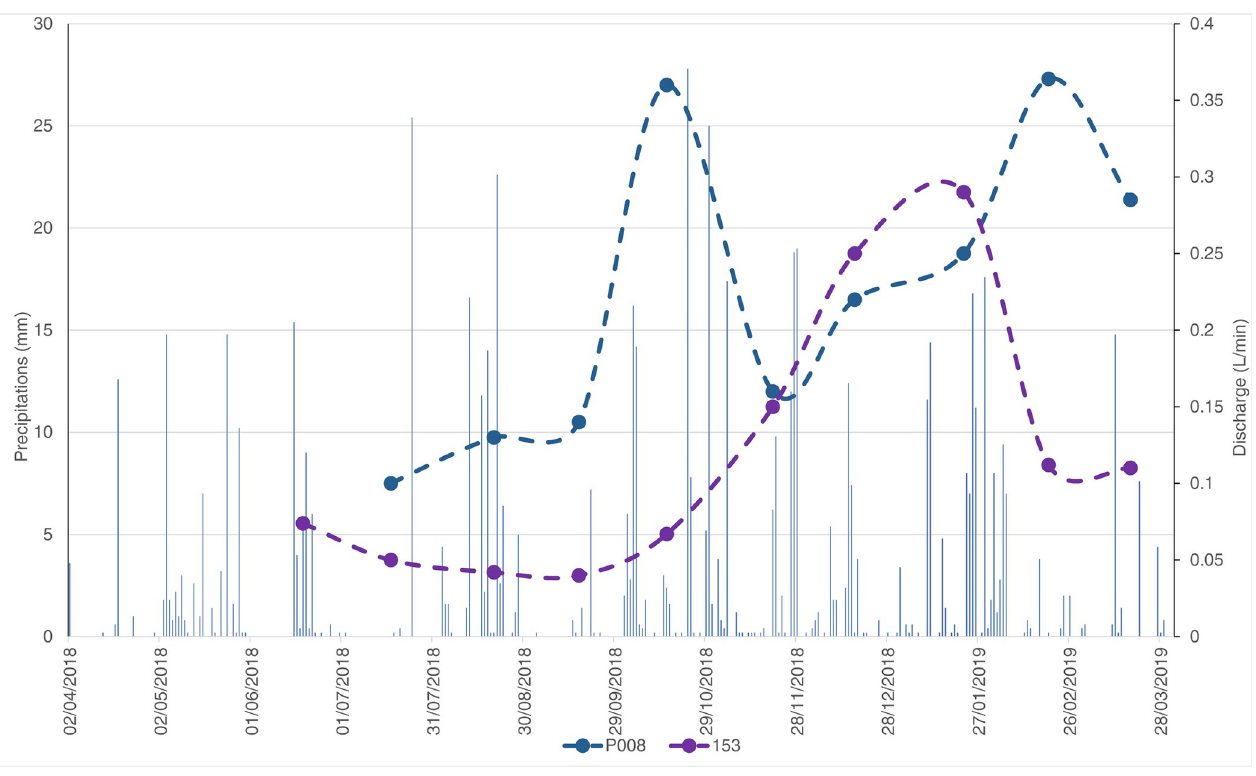
Fig 7. Examples of spring hydrographs (dates are given in